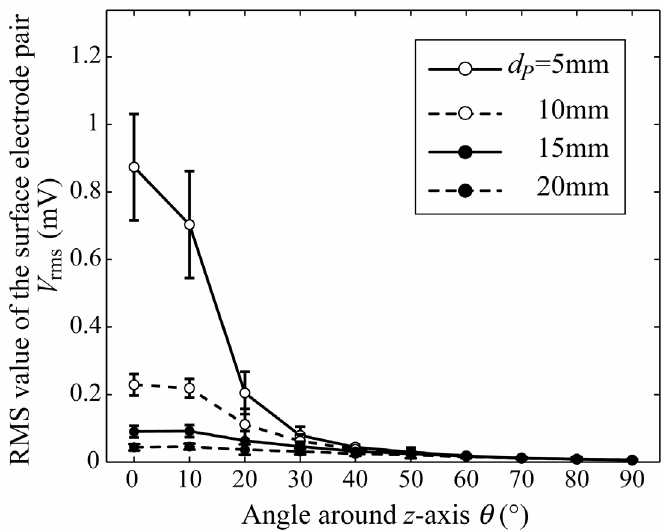
Fig. 3 Relationship between the RMS value of the surface electrode and the angle around the z -axis (20Hz of source